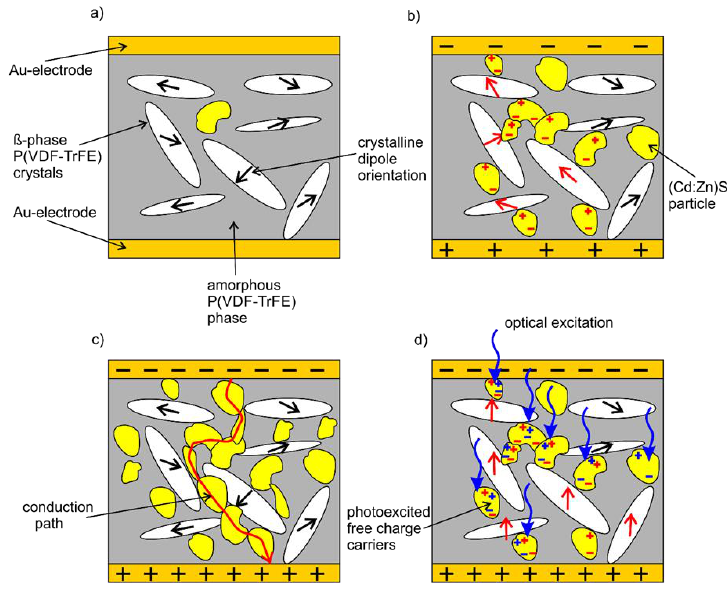
Figure 10. Schematic illustration of the proposed “three phase model”: ( a ) composite film at a (Cd:Zn)S concentration of 0, 0.1 and 1 vol % without ferroelectric behaviour at an electrical field of 50 MV/m, ( b ) dipole orientation of the ferroelectric β-phase of P(VDF-TrFE) at a (Cd:Zn)S concentration of 5, 10 and 15 vol % resulting from surface charge balancing and an increasing effective adjacent electric field, ( c ) the formation of conduction paths at a (Cd:Zn)S particle concentration of 20 vol %, and ( d ) photoexcitation of additional free charge carriers resulting in an enhanced ferroelectric behaviour at (Cd:Zn)S concentrations of 5, 10 and 15 vol %.